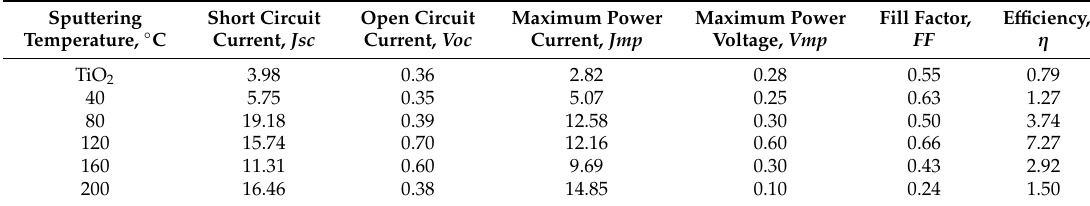
Figure 11. J-V curve of DSSCs based anatase TiO 2 and various sputtering temperatures of rGO-TiO 2 nanocomposite photoanodes film. Table 2. Summary of photovoltaic characteristics of DSSCs via di ff erent sputtering temperatures of TiO 2